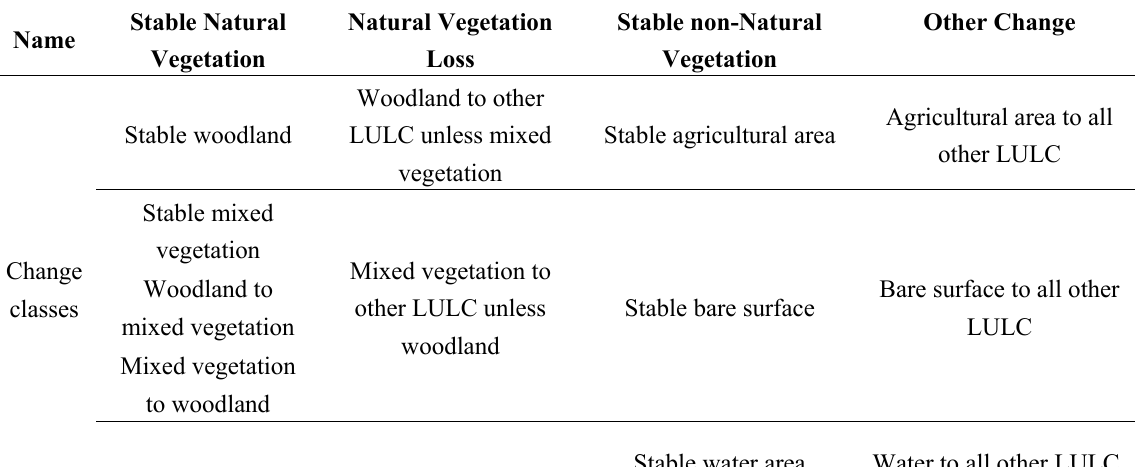
Table 6. LULC conversions included in the four LULCC classes between 1999 and